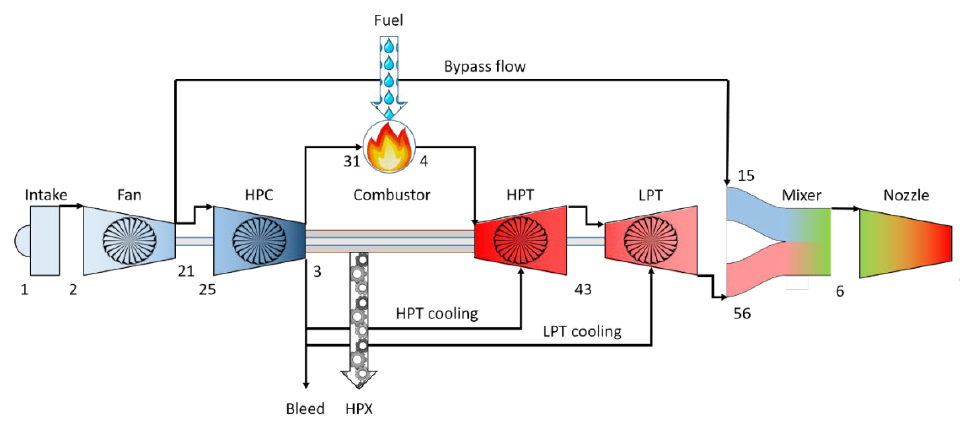
Figure 1. Layout of the gas turbine model and station numbering.